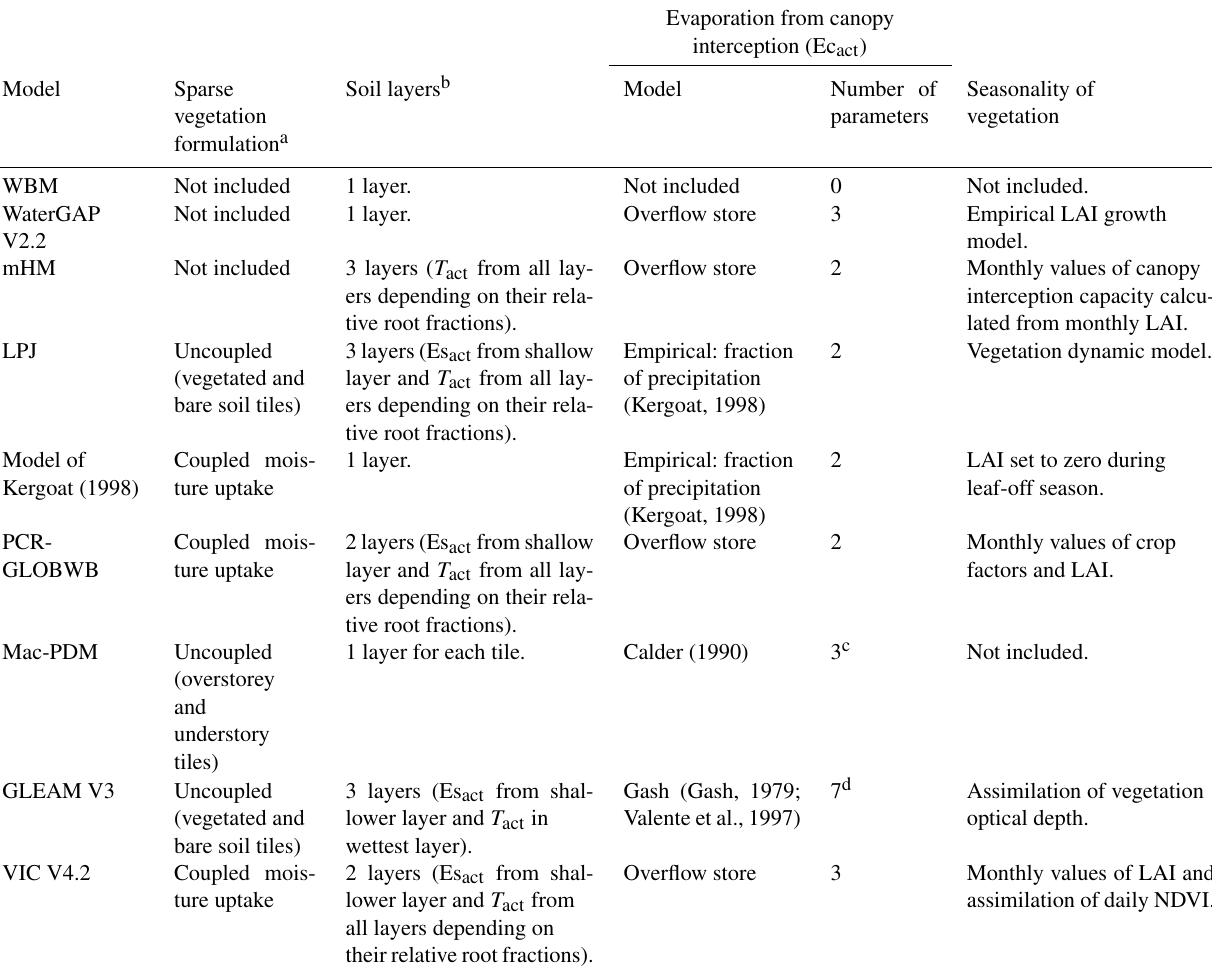
Table A3. Representation of sparse vegetation, soil layers, evaporation from canopy interception and seasonality of vegetation in the large- scale models of Table